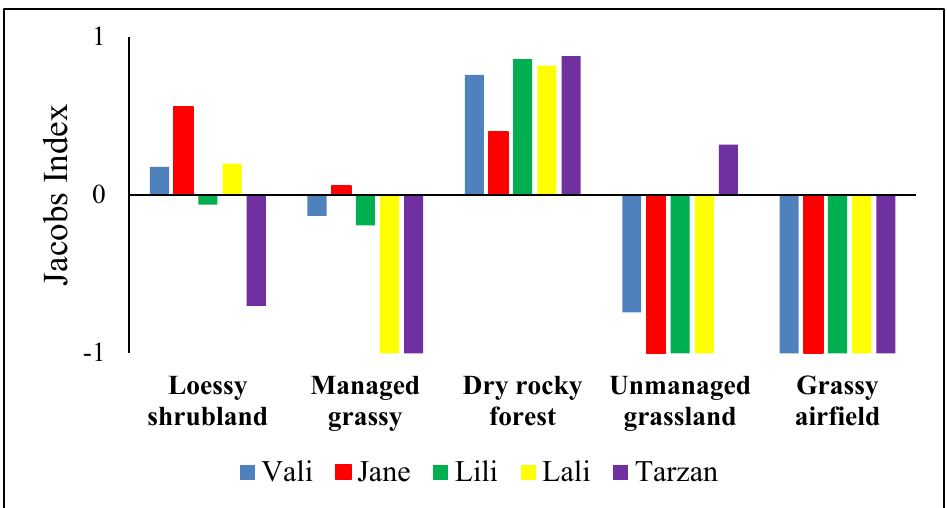
Figure 2. Jacobs’ index values showing microhabitat preferences of Caspian whipsnake ( Dolichophis caspius ) individuals in the study area.